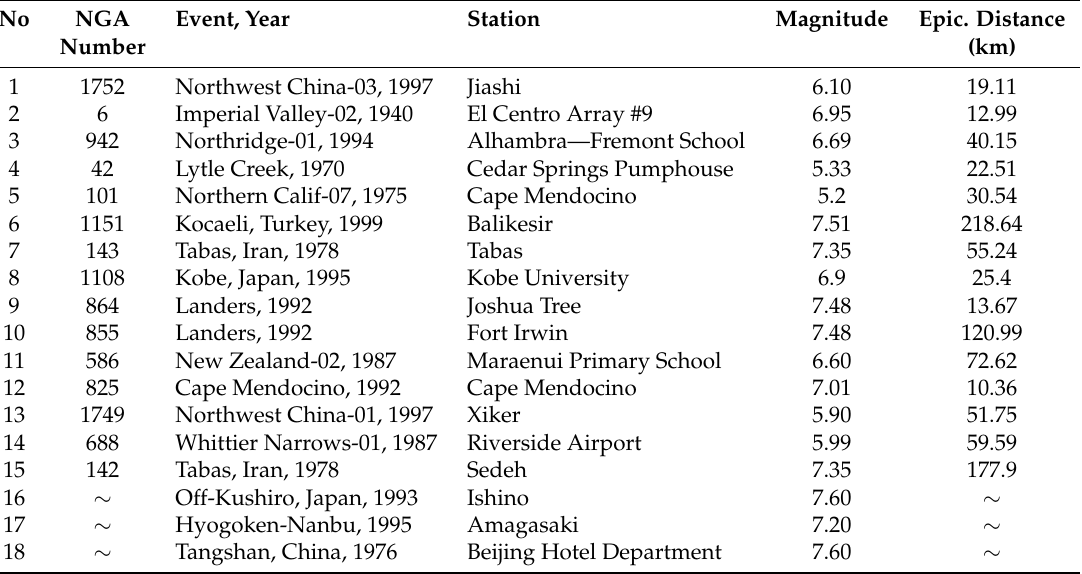
Table 1. Main information of recorded earthquake ground motions used in the study. However, to conduct the regression analysis in Section 3 we added other 250 ground motions